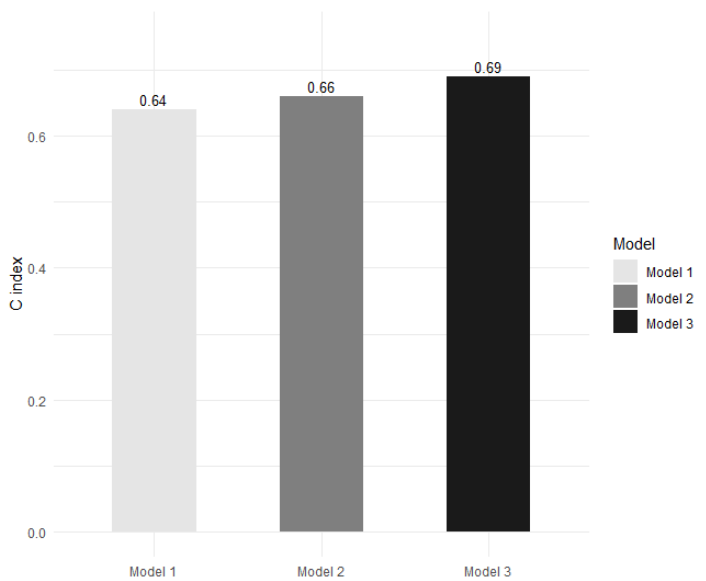
Figure 4. The Harrell’s concordance index (C index) for the prediction of major adverse cardiac events in the Framingham Risk Score (FRS)-alone model (model 1), in the FRS and coronary artery disease (CAD) model (model 2), and in the model adding dickkopf-1 (DKK-1) to FRS and CAD (model 3). Model 3 presents a significant improvement in predictive ability compared with model 2 ( p = 0.027 according to integrated discrimination improvement and p = 0.033 according to continuous net reclassification